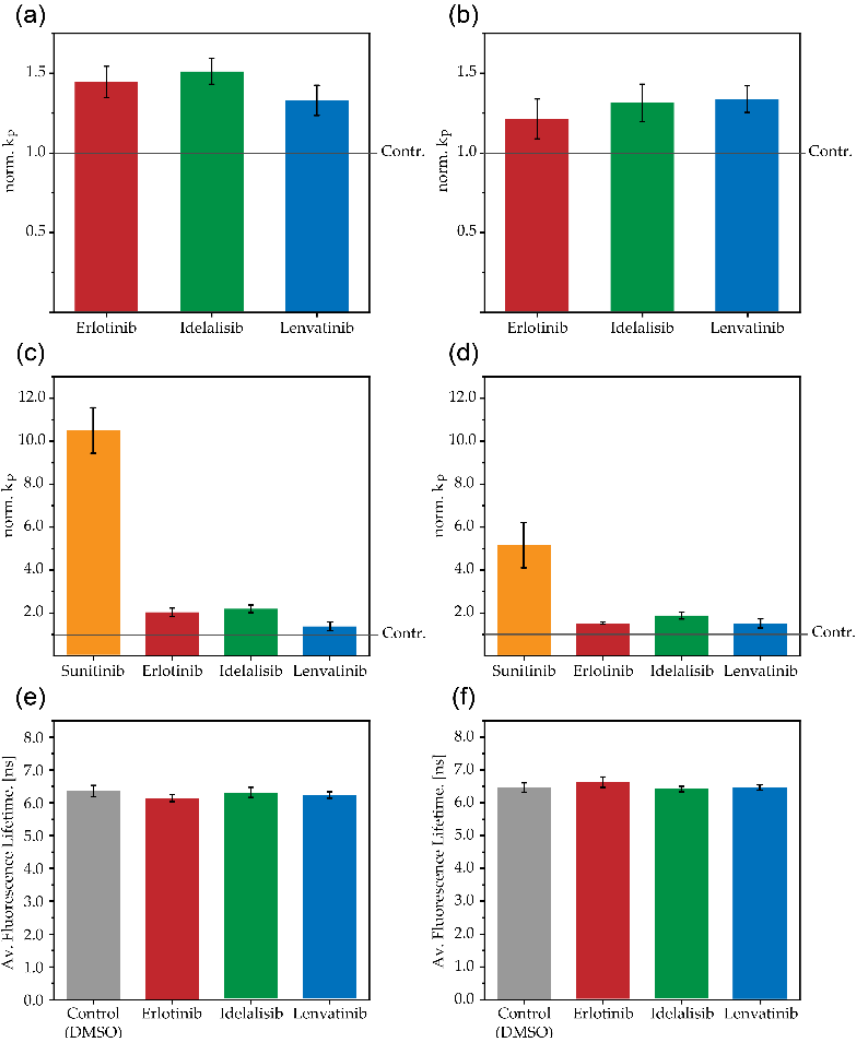
Figure 4. Influence of small-molecule kinase inhibitors on membrane properties. The membrane permeation of dithionite for POPC LUVs ( a ) and POPC/cholesterol (4:1) LUVs ( b ), and of ascorbate for POPC LUVs ( c ) and POPC/cholesterol (4:1) LUVs ( d ) was measured in the absence and presence of drugs by fluorescence and ESR spectroscopy. From experimental reduction kinetics of NBD-PC by dithionite or of spin-labeled-lipids by ascorbate measured at 37 ◦ C, the rate constants (k p ) for either anion were determined. The k p values in in the presence of respective drugs (L:D = 5:1) were normalized to those determined in the absence of the drugs (only addition of DMSO). The mean +/ − SE of three independent experiments are shown. Moreover, the average fluorescence lifetime ( τ av ) of NBD-PC labelled POPC ( e ) and POPC/cholesterol (4:1) ( f ) LUVs was measured in the absence (only addition of DMSO) or in the presence of the given drugs (L:D = 2.5:1) at 25 ◦ C. The data represent the mean +/ − SD of at least three independent